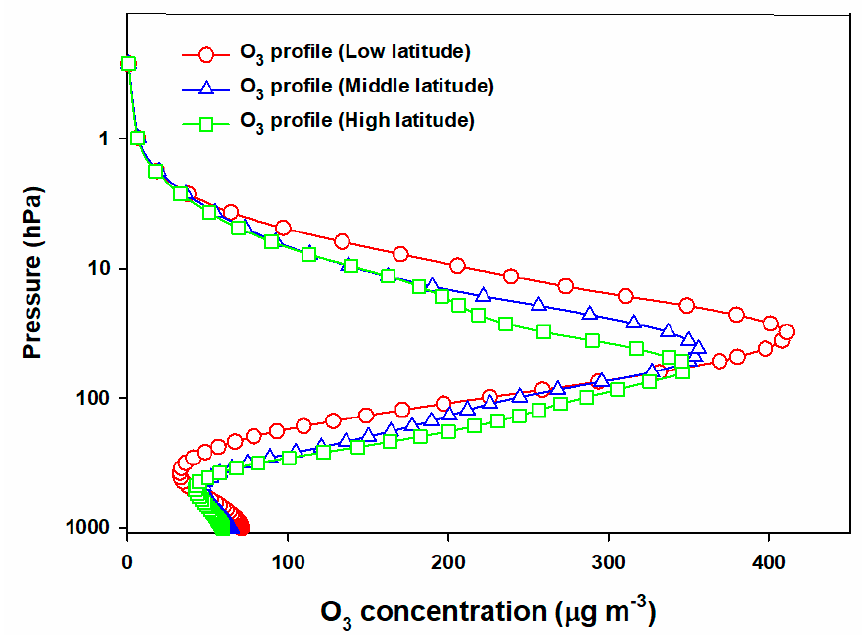
Figure 2. O 3 vertical distributions used for the SO 2 AMF calculation.